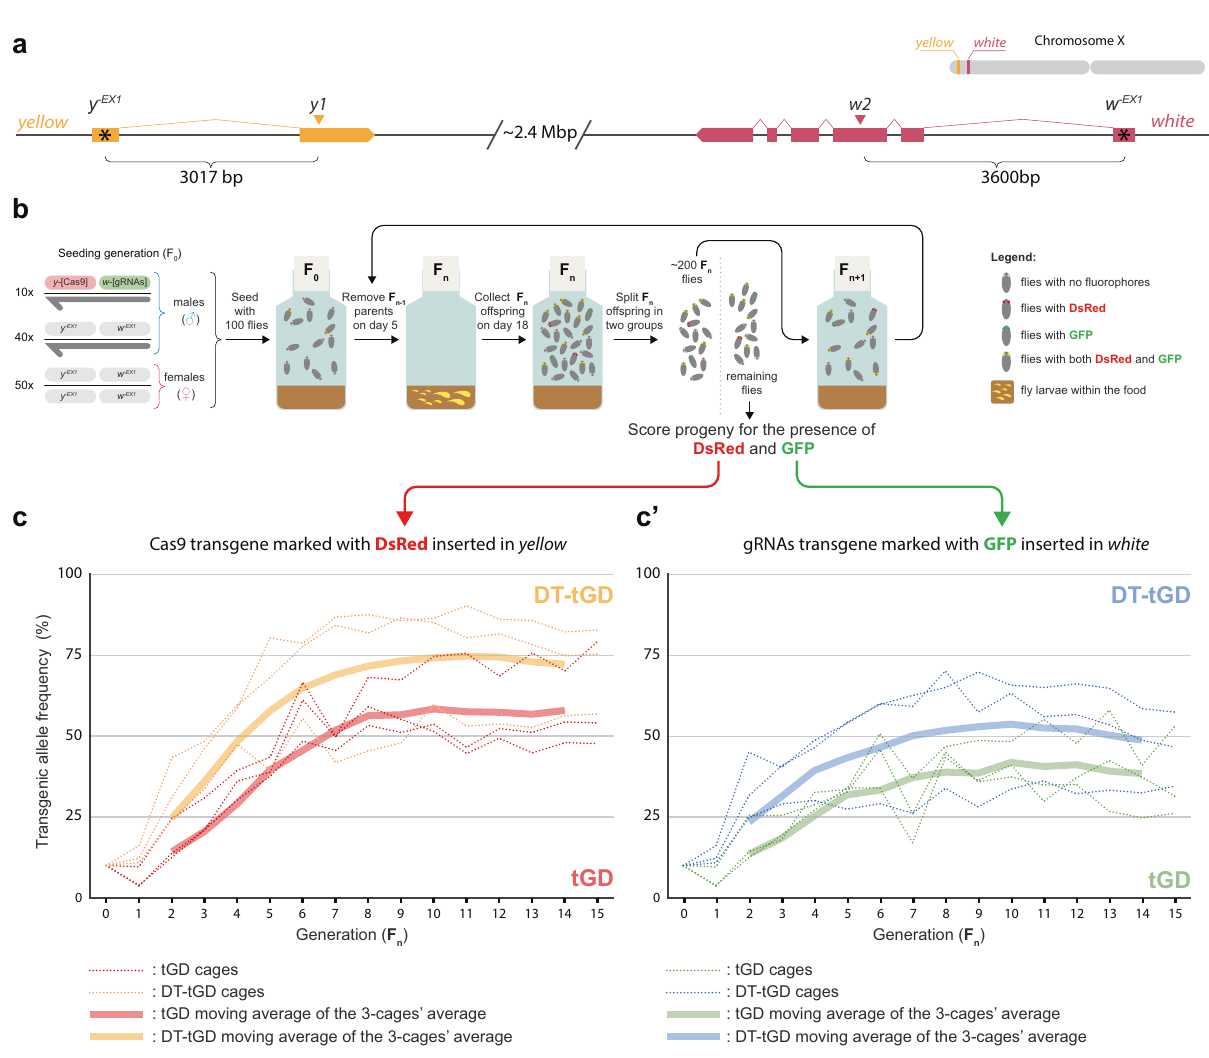
Fig. 4 tGD( y1,w2 ) and DT-tGD( y1,w2,y1b,w2b ) performance in caged populations. a Schematic of the yellow and white genomic loci, indicating the locations targeted by the y1 - and w2 -gRNAs (triangles) and the y -EX1 and w -EX1 mutations (asterisks). An approximate location of yellow and white on the X chromosome is shown on the top right of the panel. b Schematic of population experiment. Cages are seeded with 100 fl ies, including 10 males that carry both the Cas9 and gRNA drive elements. After 5 days, the adult fl ies are discarded, and the larvae are allowed to develop. On day 18, fl ies are removed from the cage and split into two groups — ~200 fl ies are randomly selected to seed the next generation; the remaining fl ies are scored for red and green fl uorescence as markers of transgene inheritance. c DsRed-marked Cas9 and c ’ GFP-marked gRNA transgene prevalence in 3 independent populations per condition, tracked over 15 generations by scoring the two fl uorescent markers. Dotted lines represent 3 independent cages. Fat solid lines represent the moving average of the 3 cages ’